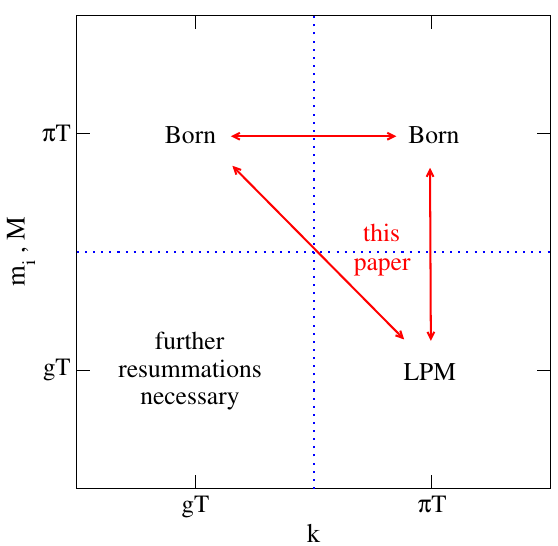
Figure 1 . An overview of various momentum and mass domains, with g (cid:28) π denoting a generic coupling. The interpolation introduced in section 4 can be used in three of the four quadrants shown, but does not apply when all masses and momenta are very small (blindly extrapolating the interpolant into that quadrant, the result could even become negative, which is